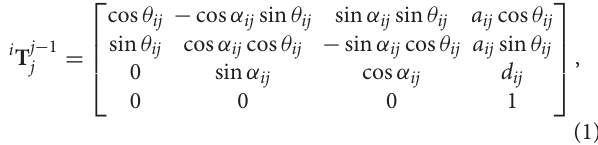
TABLE 1 | Technical specifications of the prototype. Parameter Number of servo motor